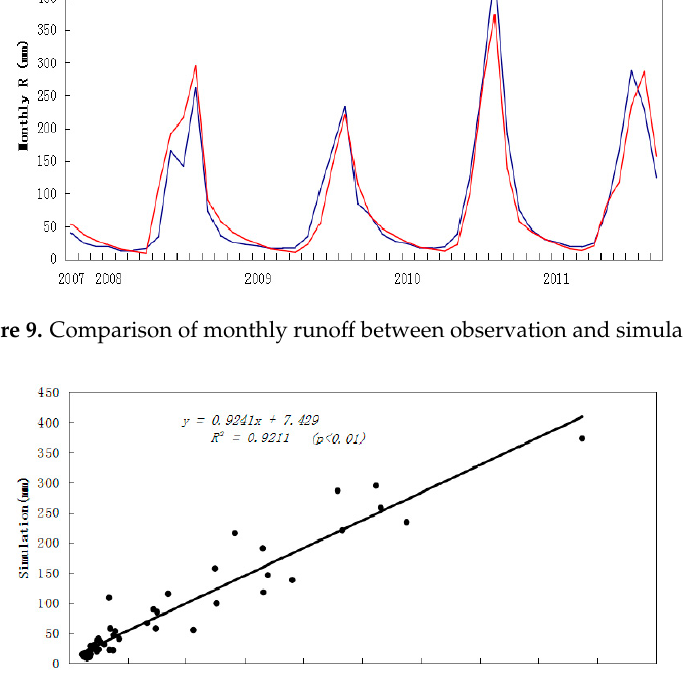
Figure 10. Comparison of monthly simulated ( R sim ) and observed runoff depth ( R obs ) from 2007 to 2011.